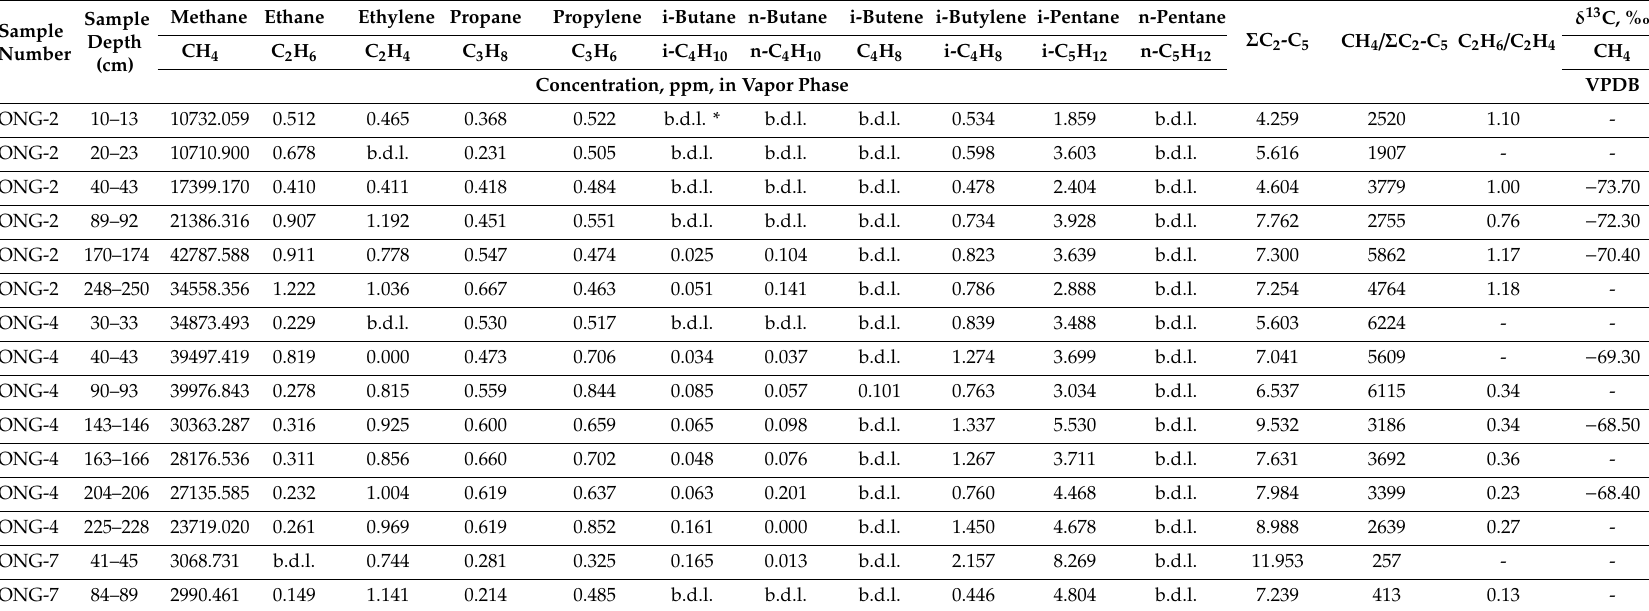
Table 3. Composition of gases taken from the cores ONG-2, ONG-4 and ONG-7 of the Petrozavodsk